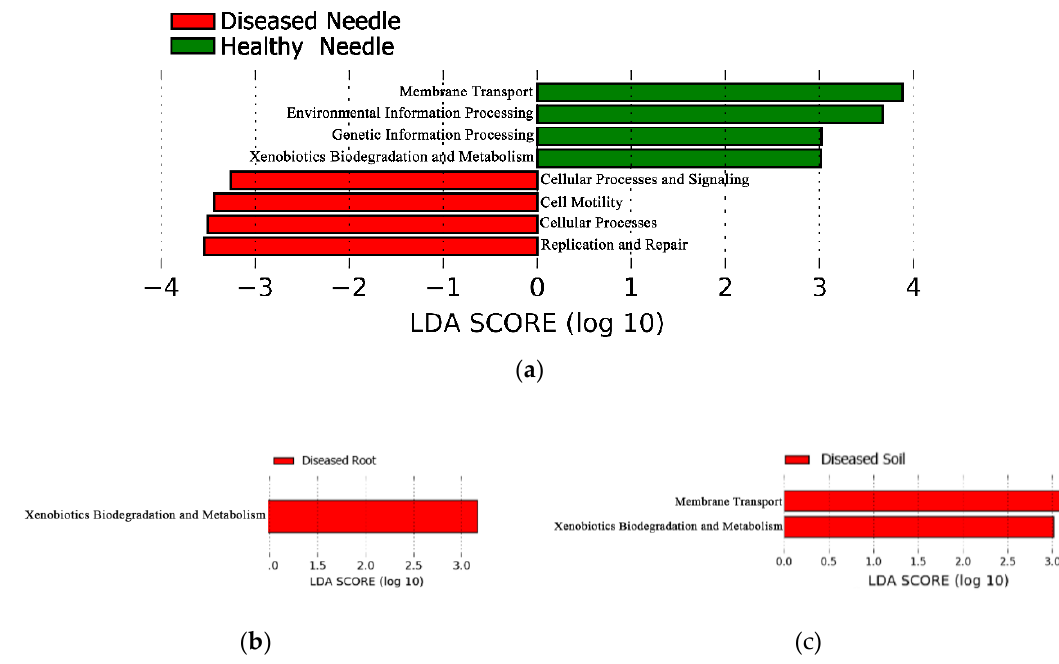
Figure 5. Lefse analysis showing the predicted functional groups significantly presented for healthy and diseased samples in the needles ( a ), roots ( b ), and soil ( c ).